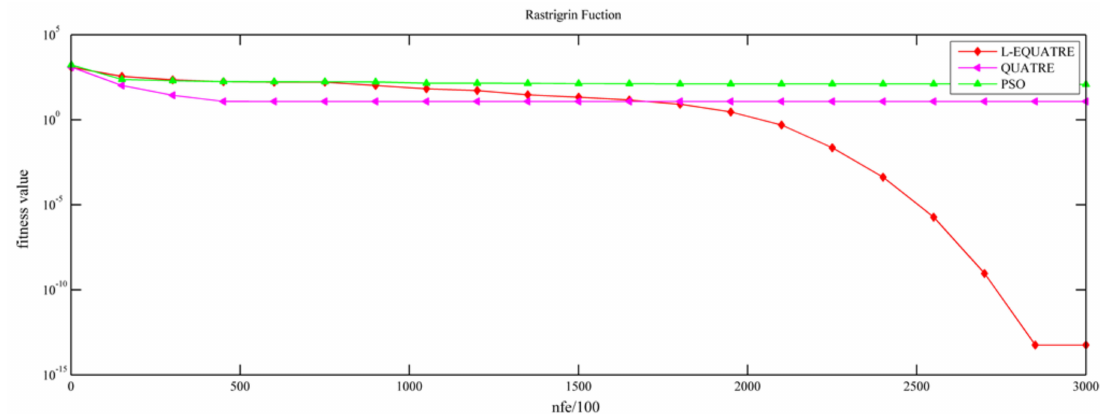
Figure 4. Rastrigrin